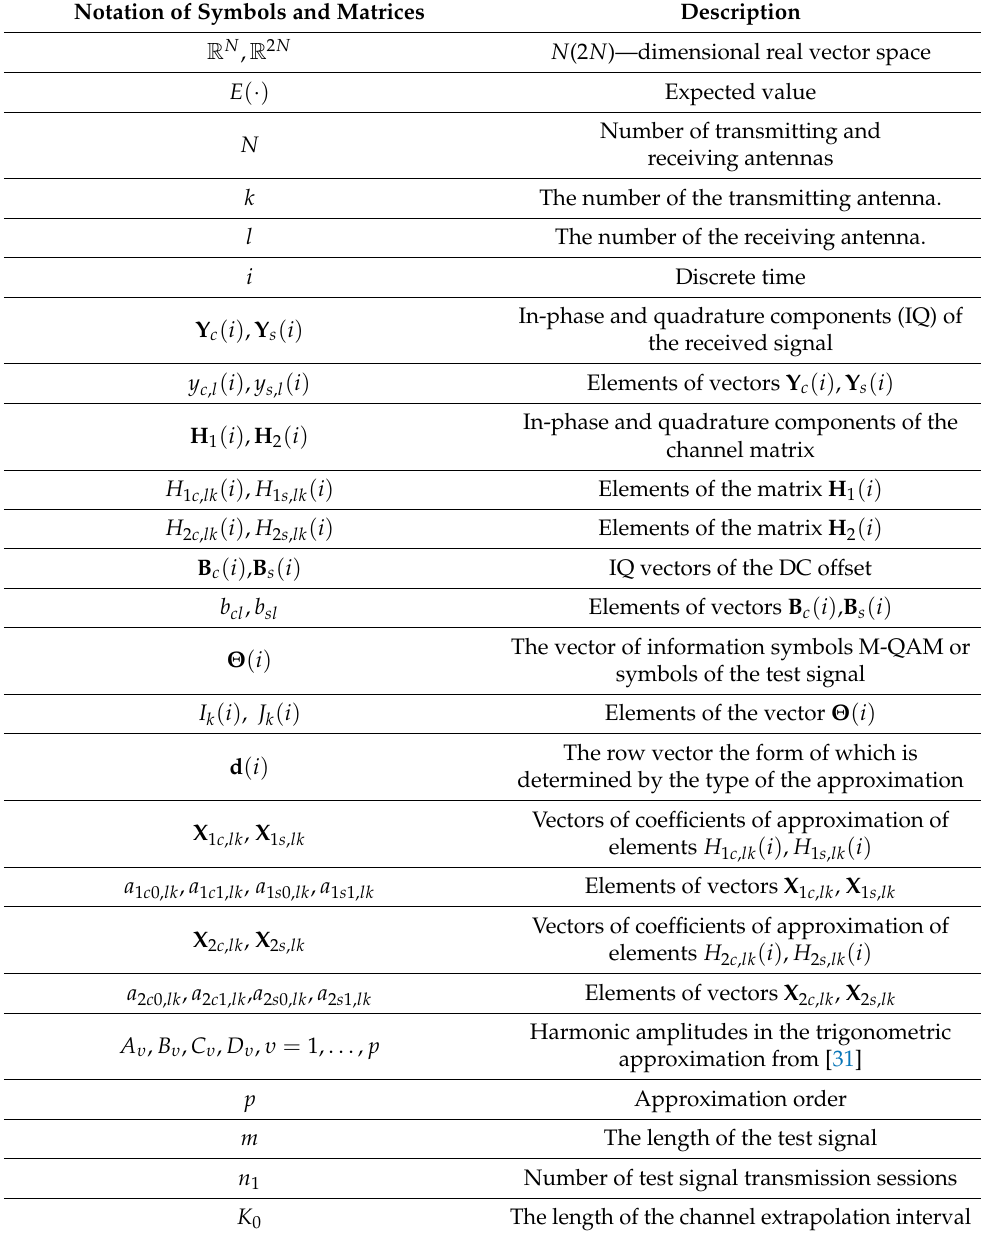
Table 1. Symbols, vectors, and matrices used in this